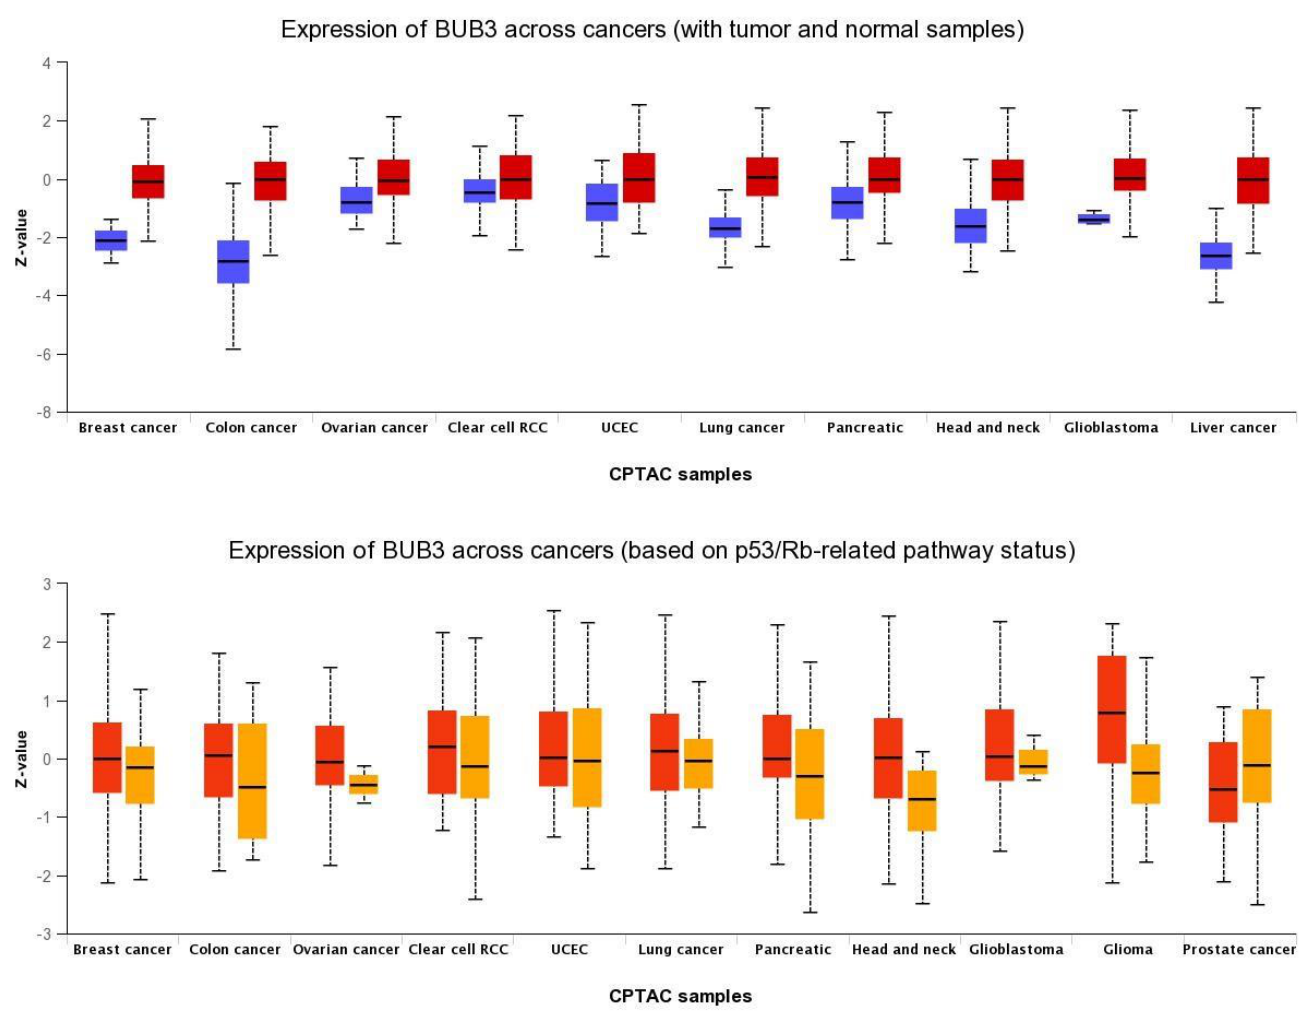
Figure 3. Pan-cancer view of expression of BUB3 protein across cancers. ( Upper panel ) Comparison between normal (blue) and primary tumors (red); ( lower panel ) Comparison between TP53-mutant (red) and TP53-non-mutant (orange) tumor samples. RCC: renal cell carcinoma; UCEC: Uterine corpus endometrial carcinoma; CPTAC: Clinical Proteomic Tumor Analysis Consortium. Data were retrieved from UALCAN portal (http://ualcan.path.uab.edu/index.html) on 24 December 2021.